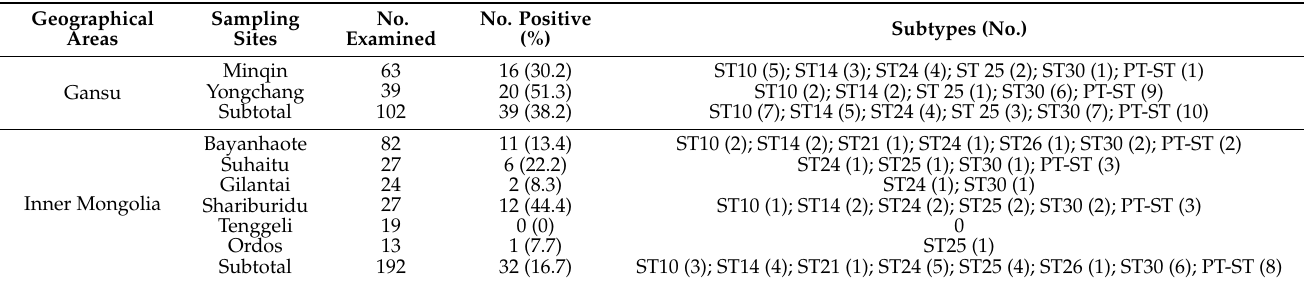
Table 1. Occurrence of Blastocystis sp. in Camelus bactrianus in